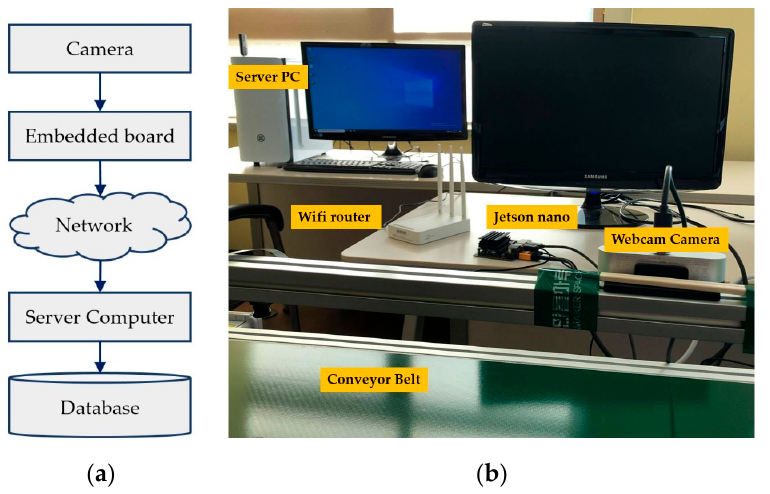
Figure 4. Data collection system: ( a ) Data collection diagram; ( b ) Data collection system setup.